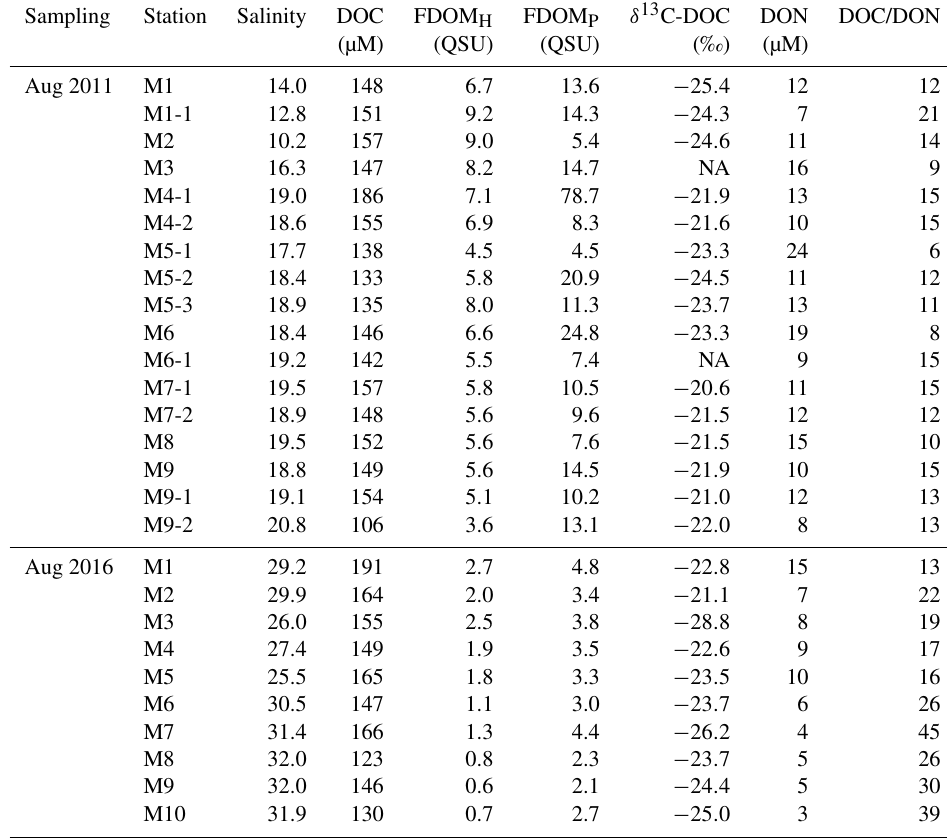
Table 1. Salinity, DOC, FDOM H , FDOM P , δ 13 C-DOC, DON, and the DOC / DON ratio in surface water of Masan Bay in August 2011 and August 2016.